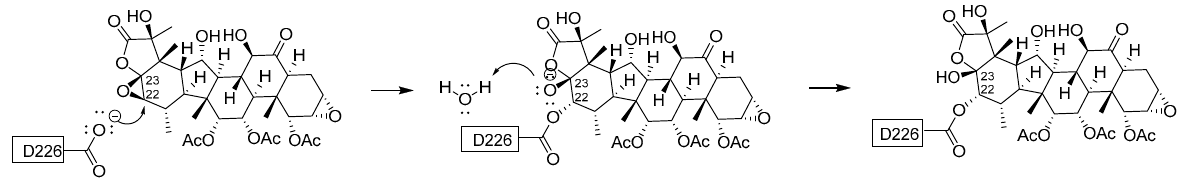
Figure 7. Proposed mechanism for the addition of Asp226 to taccalonolide AJ. Based on binding energy analysis, residues of β -tubulin His229, Leu217, Leu219, Leu230, Leu371, Pro360, Phe272, and Leu275 are identified as a determinant of the orienta- tion of AJ in the [TAJ:( α 1- β 1- α 2)] 2 complex. His229, Asp226, Arg278, Lys19, and Arg369 are in favorable contact with AJ. The simulation reveals that the hydrogen bonds are formed between the C2–C3 epoxide and the side chains of Lys19 and Glu22 in helix H1 as well as Asp26 and Glu27 [17]. The C6 carbonyl and the oxygen of the C1 acetyl moiety also engage in a long-lived water-mediated hydrogen bond to Asp26 and Pro274, respectively